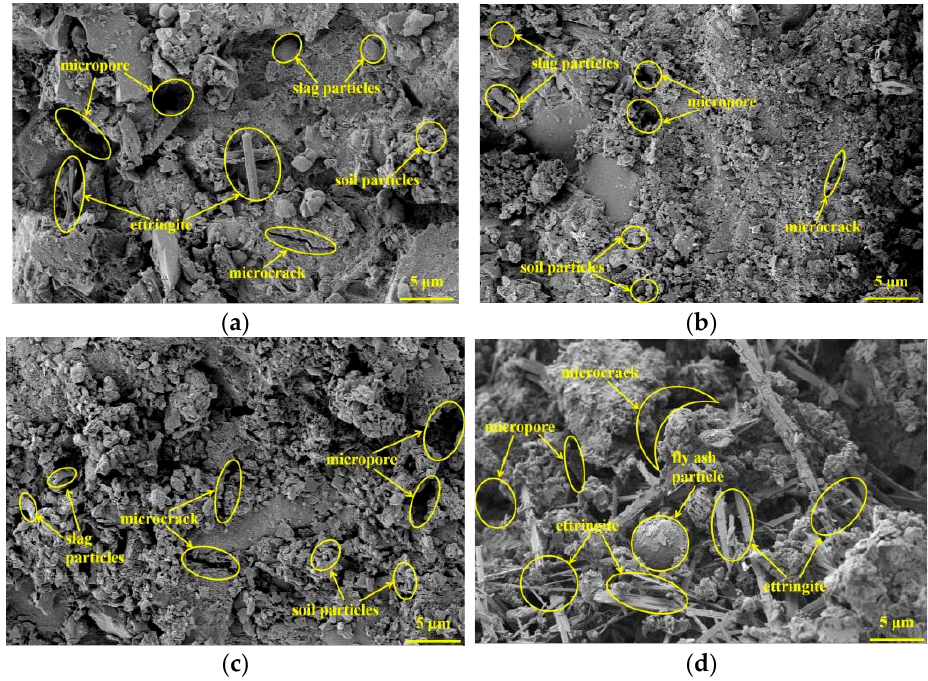
Figure 11. SEM analysis of SF-GSSS immersed in a Na 2 SO 4 solution for 60 days: ( a ) S10F0; ( b ) S9F1; ( c ) S8F2; and ( d ) S7F3.